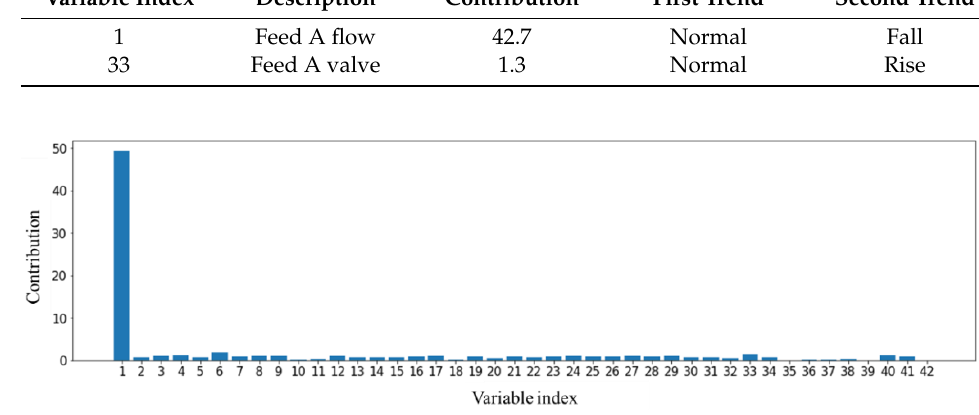
Figure 13. Contributions of variables in 2 min for Mode 5 fault 6.